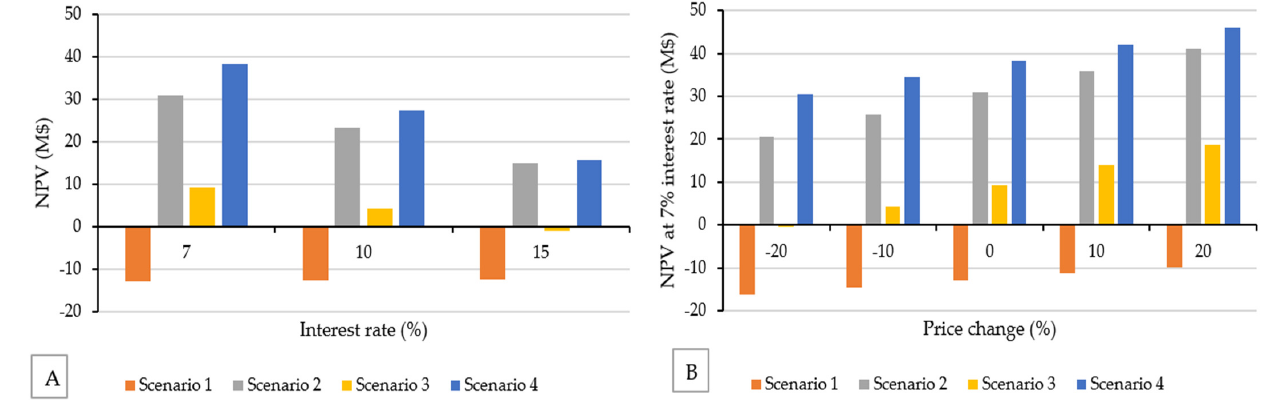
Figure 2. Relationship between NPV with interest rates ( A ) and price change of main products ( B ) for each case scenario. Scenario 1: direct CHP generation from wood sawdust and shavings; Scenario 2: wood pellet production without CHP; Scenario 3: production of pellets and CHP from steam-exploded wood; Scenario 4: production of pellets and CHP from torrefied wood.